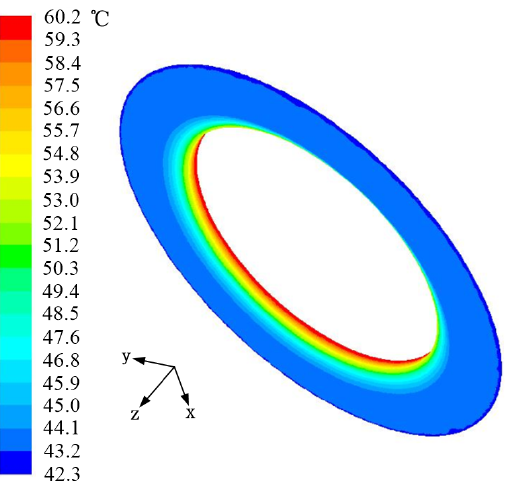
Figure 9. Temperature distribution of the copper screen.